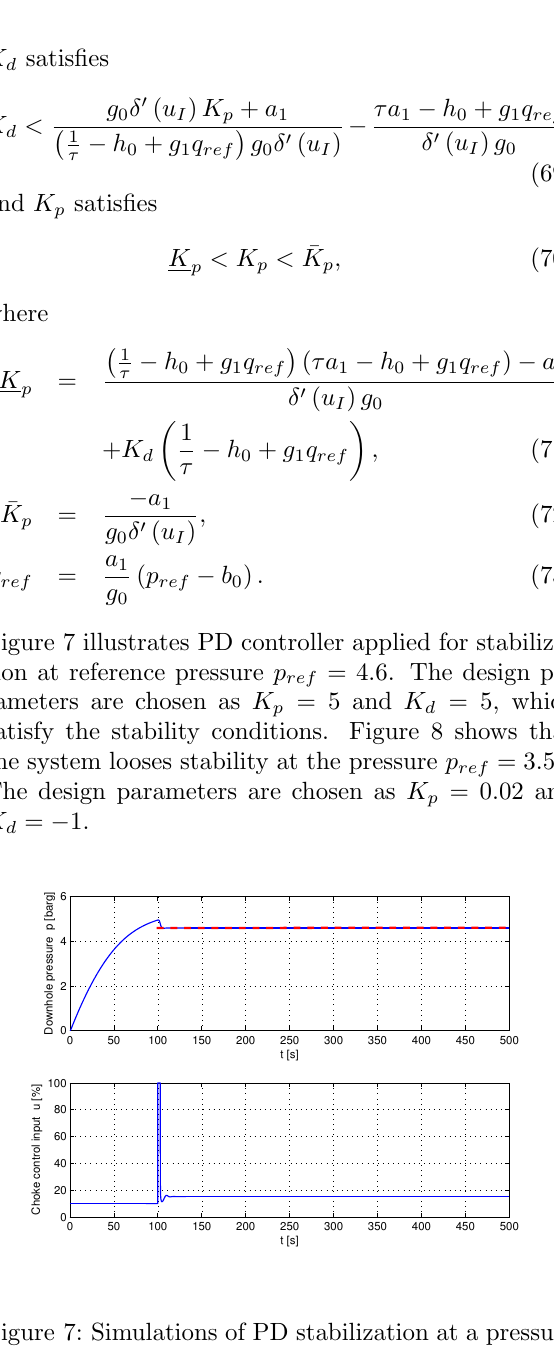
Figure 7: Simulations of PD stabilization at a pressure p ref = 4 . 60 using PD controller.